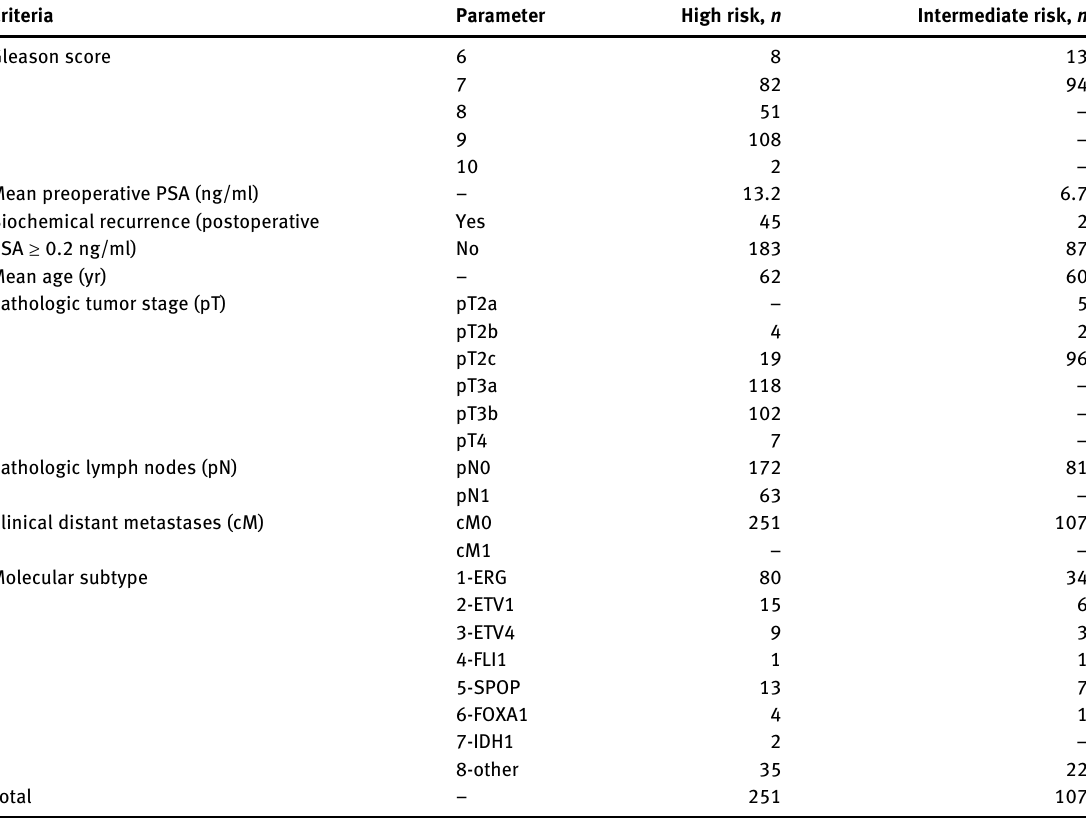
Table  : Clinicopathologic characteristics of the cohort.